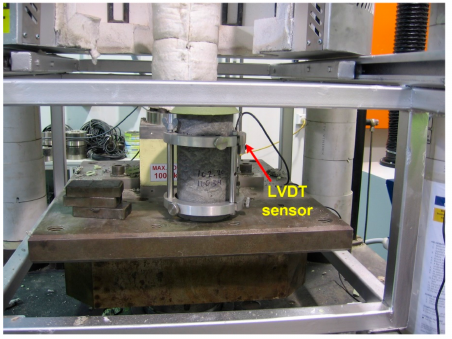
Figure 4. Photo of experimental fixture of modulus of elasticity